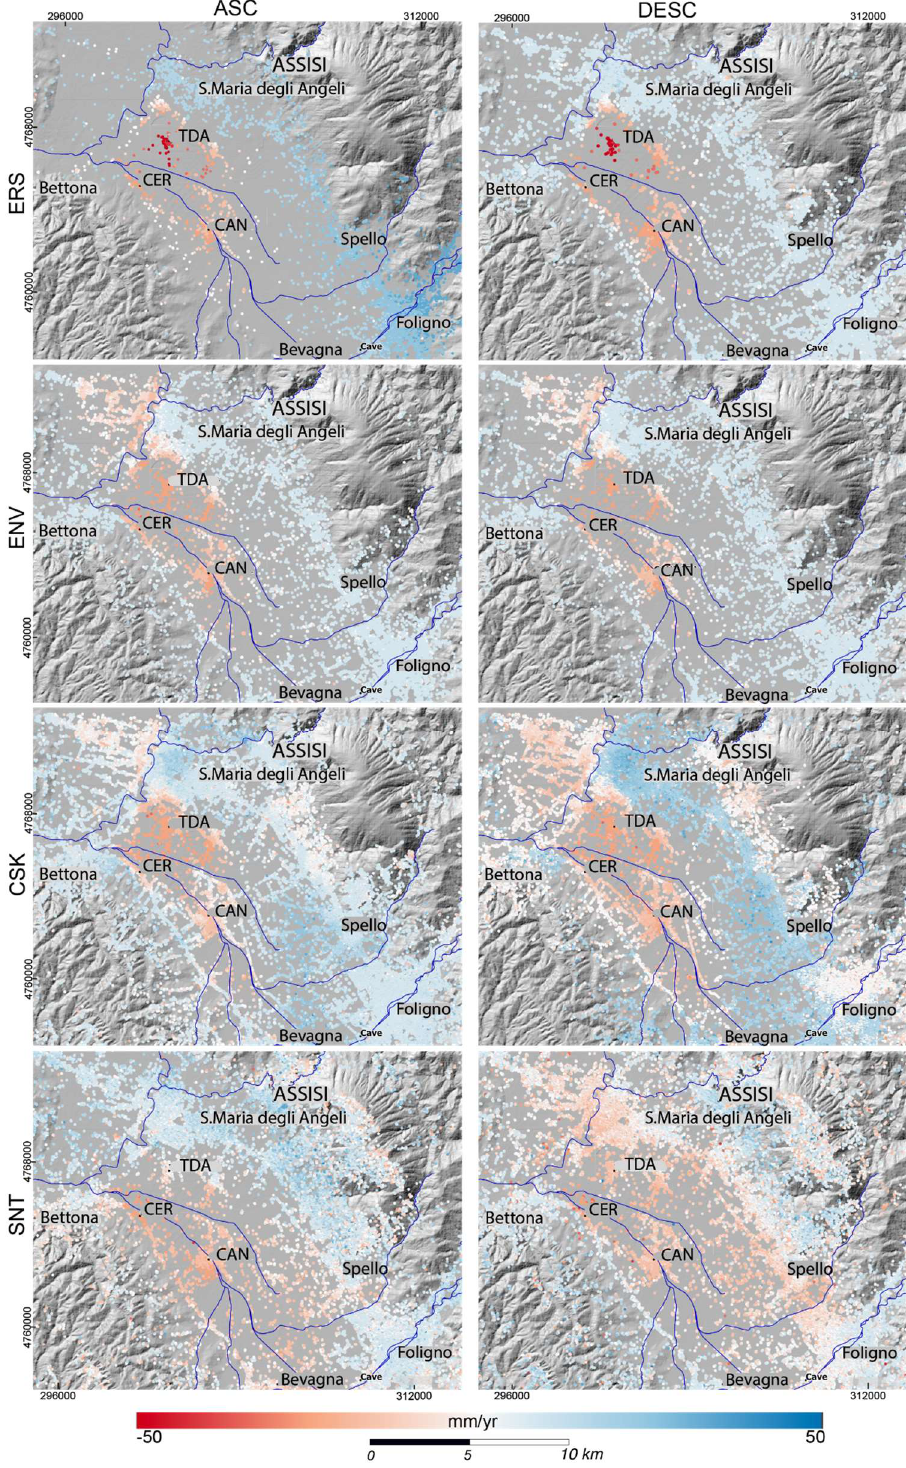
Figure 3. Velocity maps in the LOS direction for each of the PS datasets were retrieved from the independent processing of the ascending ( left panels) and descending ( right panels) SAR image stacks.